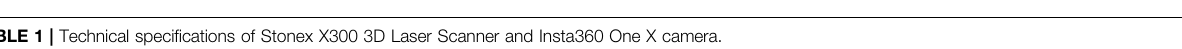
TABLE 1 | Technical speci fi cations of Stonex X300 3D Laser Scanner and Insta360 One X